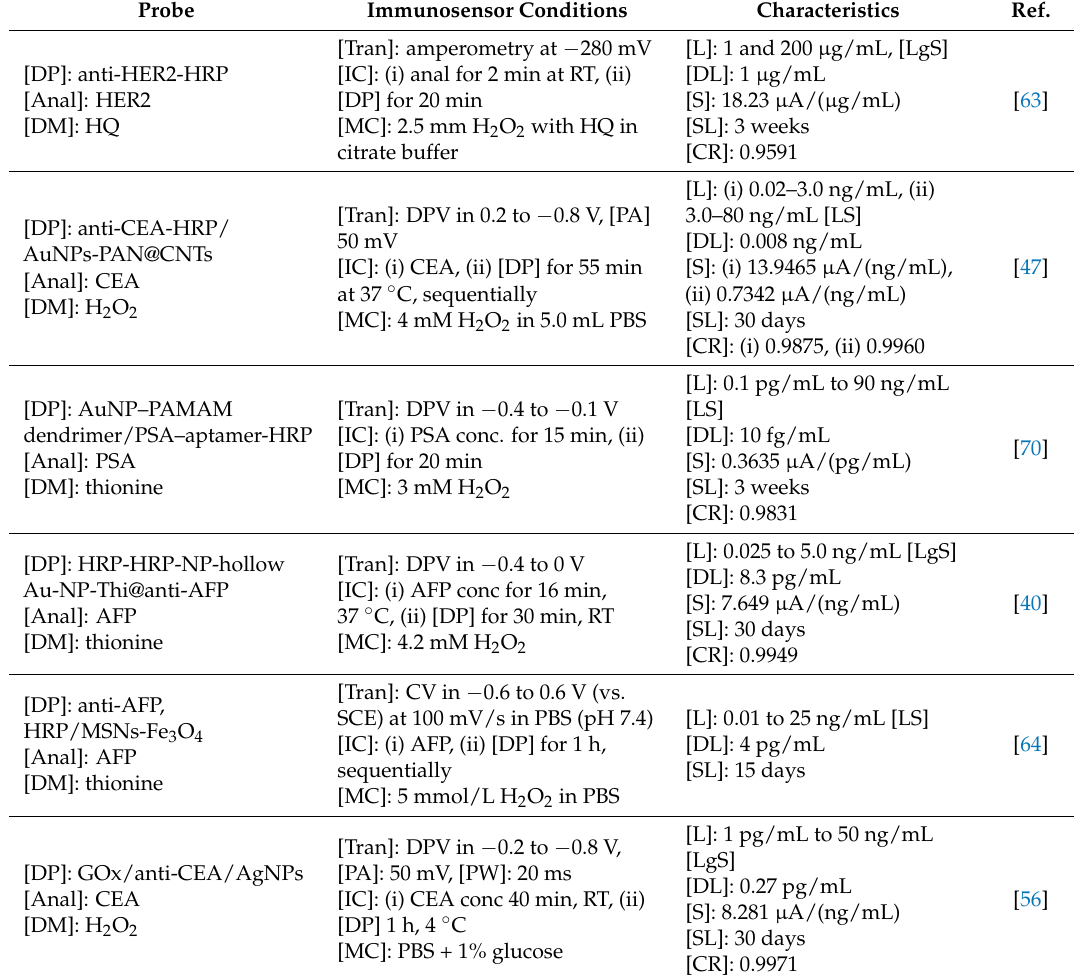
Table 3. Characteristics of the developed immunoassays using electrochemical ELISA. Probe Characteristics